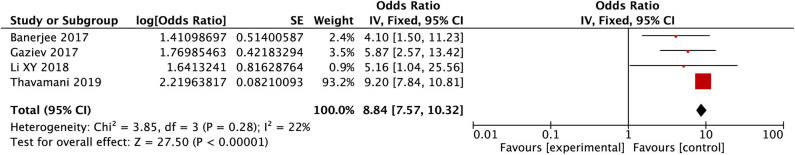
Forest plot for the incidence of hypertension. There is no obvious heterogeneity between the 4 records.